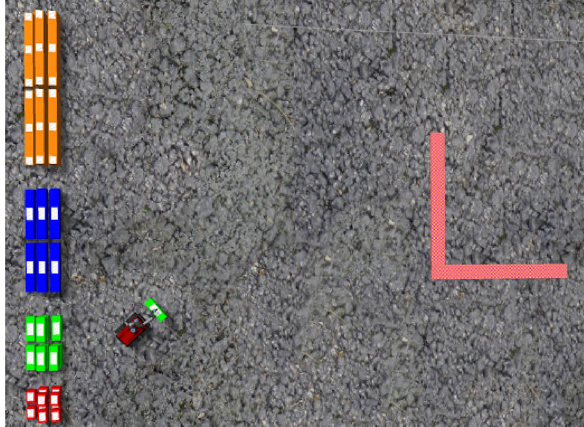
Fig. 15 Challenge 2 simulated Gazebo world with realistic meas- urements. The image represents an arena of 15x12